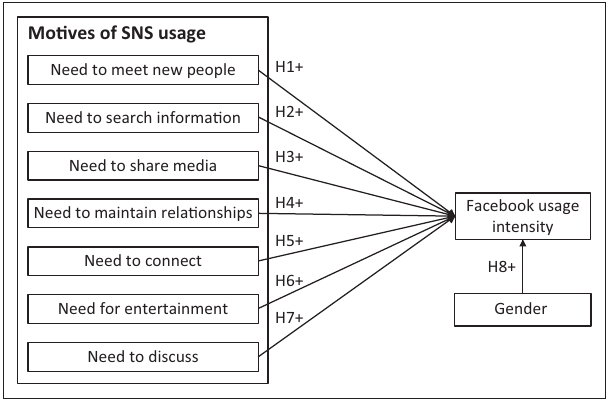
FIGURE 1: Motives for Facebook